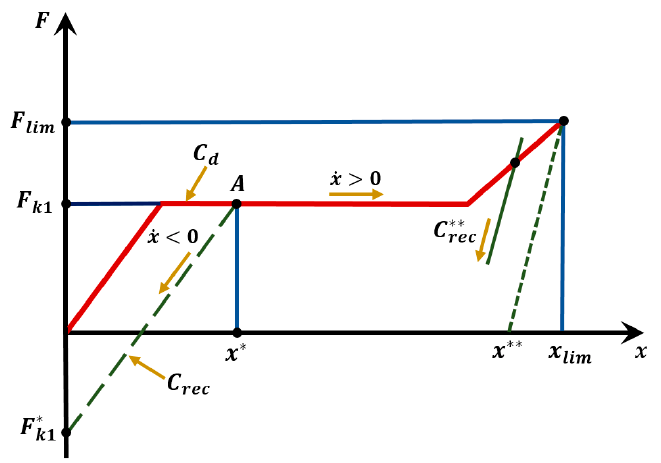
Figure 13. Description of element deformations used in the dynamic model of distributed masses. The adjustment of description of the crumple zone properties enabled more accurate reflection of the effect of changes in element properties on the deformation process of the entire crumple zone and on the overloading of the part of the 3rd crumple zone that was directly related to the crew. In this case, the elastic deformation model was used before plas- tic deformation emerged. After the plastic deformation started, the deformation progress . x > 0 then C = C d F k = F k calculation was altered depending on the process velocity: if , 1 ; . x < 0 then C = C d F k = F ∗ if . During the change of the deformation velocity sign, , k 1 value x ∗ was registered, and the calculation was then performed using C = C rec , F k = F ∗ , k 1 . x sign, until the value was higher than x *. After x * had been reached, the irrespective of the deformation process returned to the former conditions and C = C d , F k = F k 1